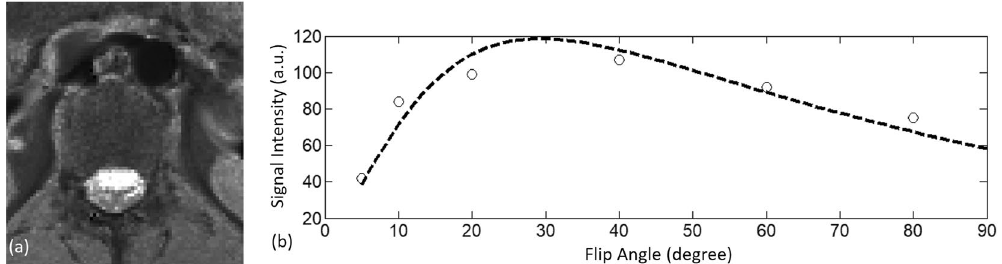
Figure 2. A T1 map ( a ) was generated from a pixel-by-pixel curve fitting of a signal-intensity-flip-angle curve ( b